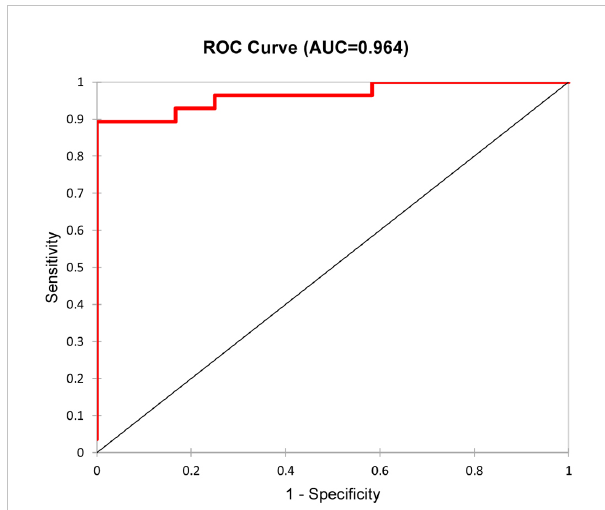
FIGURE 1 Discrimination of Focal class from the other classes with fi ve selected urine biomarkers/ROC curve.